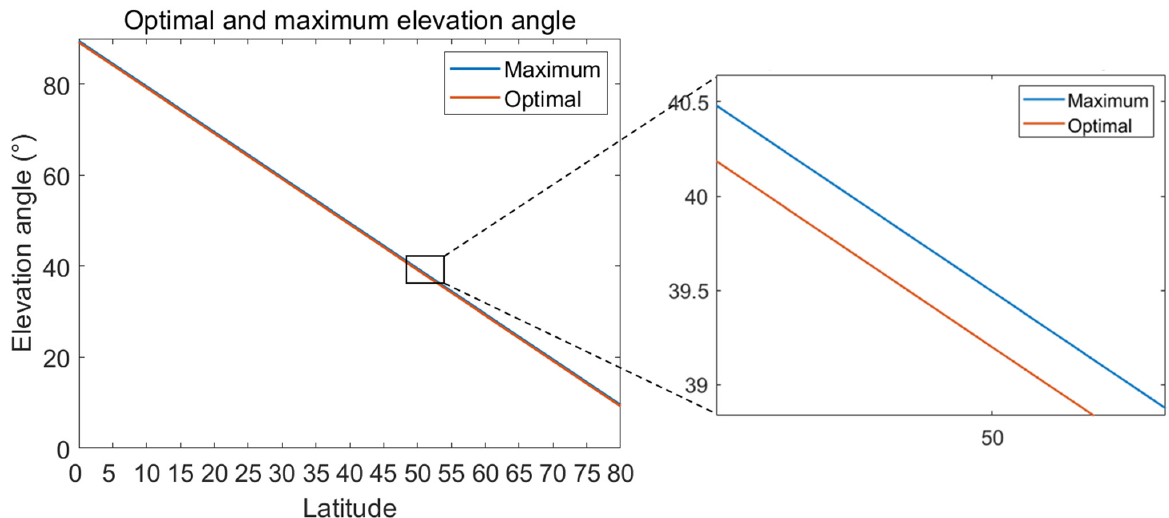
Figure 9. The variation of the optimal orientation angle with latitude. The horizontal coordinates indicate different latitudes, and the vertical coordinates indicate the best tilt angle and the best azimuth angle, respectively.